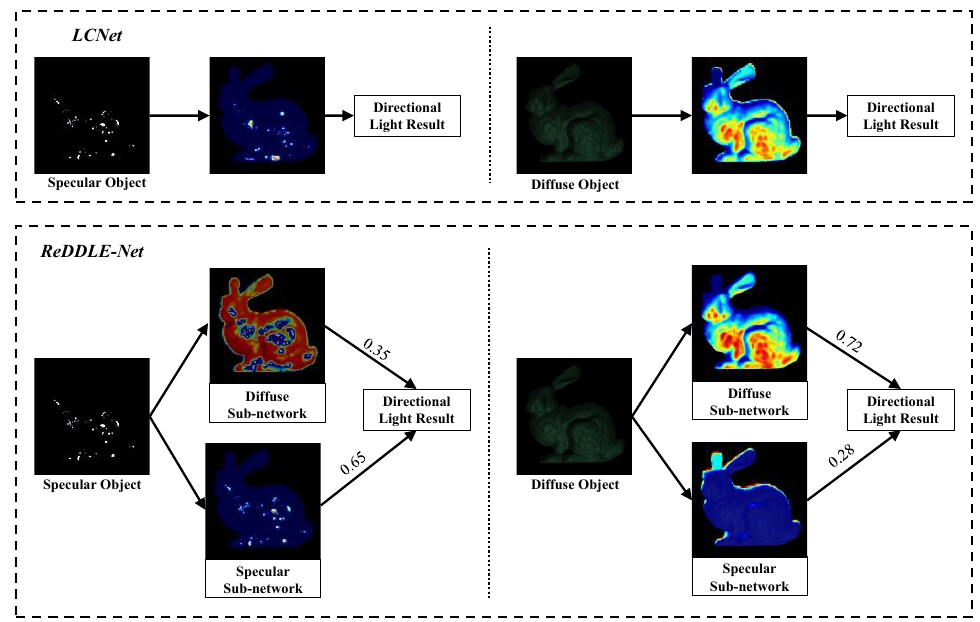
Figure 1. A comparison of the workflows of LCNet and ReDDLE-Net. LCNet uses a single-branch structure to extract features, while our ReDDLE-Net uses two-branch feature extractors (diffuse sub- network and specular sub-network). The number indicates the reflectance weight calculated by the reflectance decomposition (ReD) mechanism of ReDDLE-Net, which represents the contributions of the diffuse sub-network and specular sub-network. Top left: For a specular object, the LCNet focuses only on the highlighted part. Bottom left: ReDDLE-Net extracts diffuse and specular information using two separate sub-networks. The ReD mechanism gives a larger reward to the estimated light from the specular branch than that from the diffuse branch. Top right: For a diffuse object, the LCNet focuses on the diffuse part. Bottom right: When the object’s surface is diffuse, the ReD mechanism pays more attention to the diffuse component and improves the contribution of the diffuse